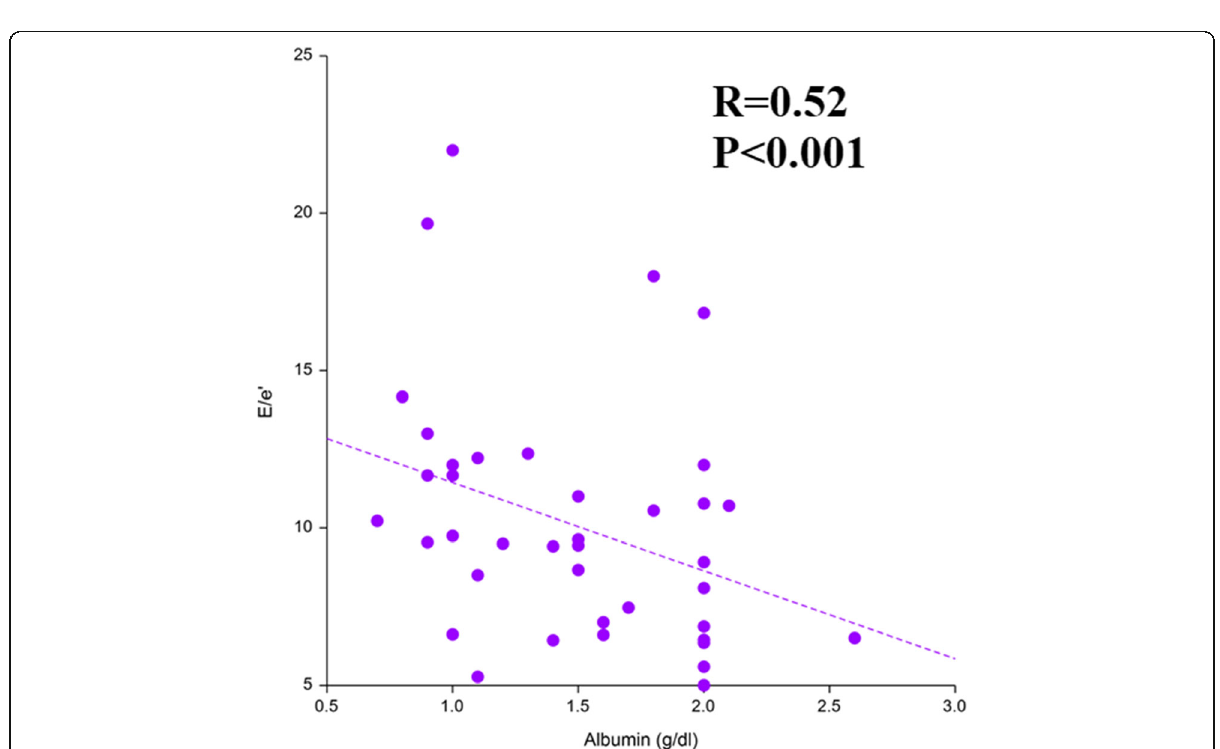
Fig. 2 Scatter plot showing the relationship between E/e ′ ratio and serum albumin. Abbreviations: E/e ′ , ratio between early transmitral inflow velocity and average early diastolic mitral annular and basal septal